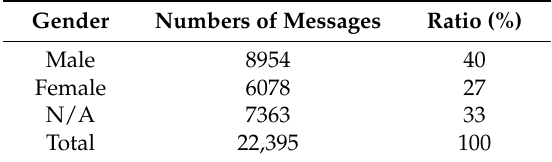
Table 1. The gender information disclosed in an AIDS-related web